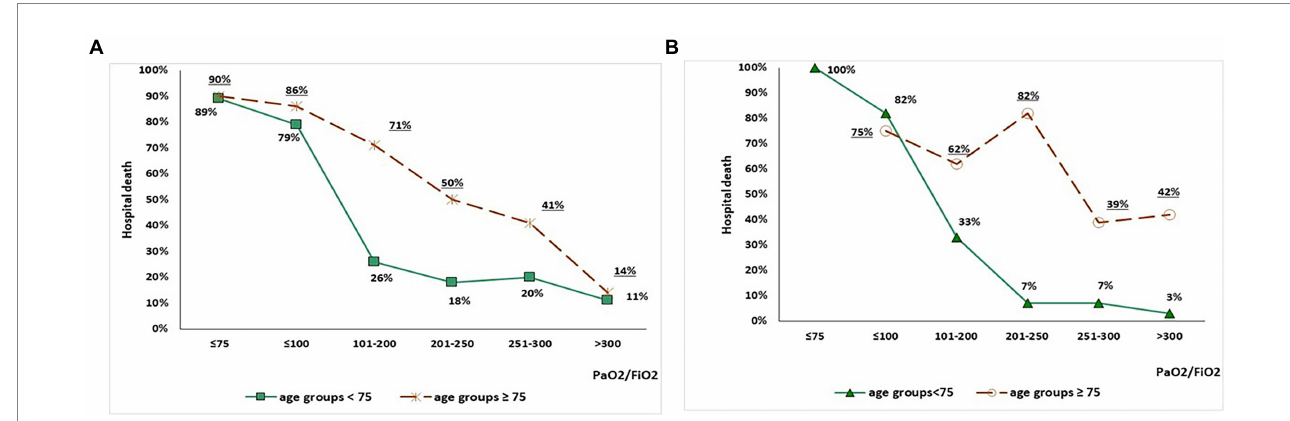
FIGURE 1 Association between P/F values on admission arterial blood gas analysis and mortality in the 2020 group (panel A) and 2021 group (panel B), stratified by age (< 75 vs. ≥ 75 years